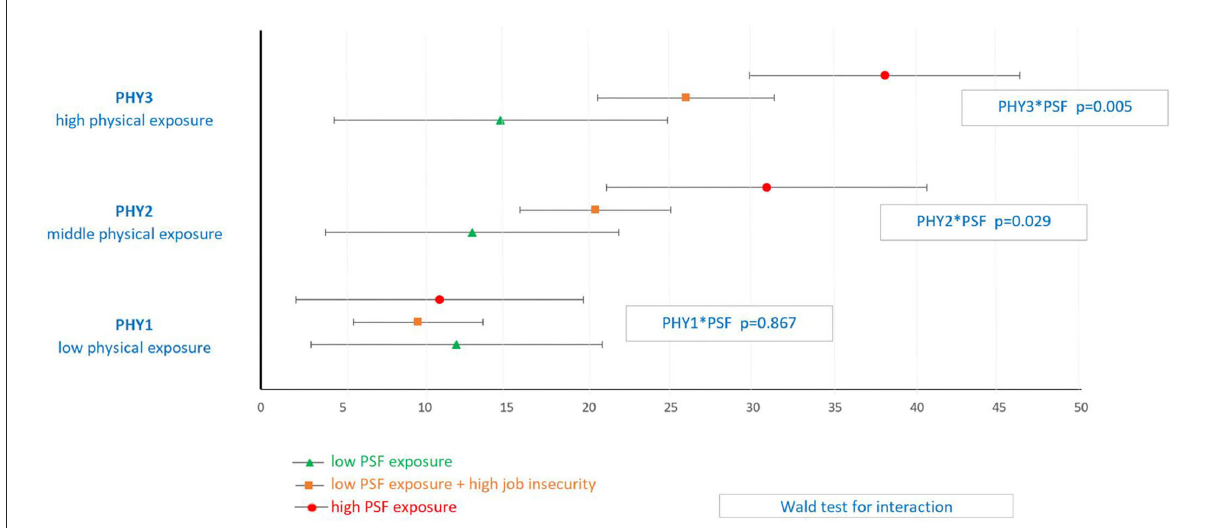
FIGURE1 Model predicted rate of workplace injuries for each level of physical (PHY) and psychosocial (PSF) exposure among Care workers a . a Poisson regression model with adjustment for covariates: gender, age class, educational level, work contract, seniority, sleep problem and use of psychotropic drugs, with an offset (duration of work weighted by part-time